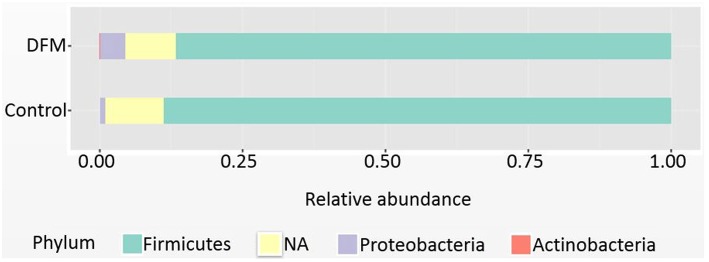
Relative abundance of major phyla recovered in ceca of broiler chickens at day 10 from two different treatment groups (control and DFM). NA refers to those reads that could not be assigned to any phyla.